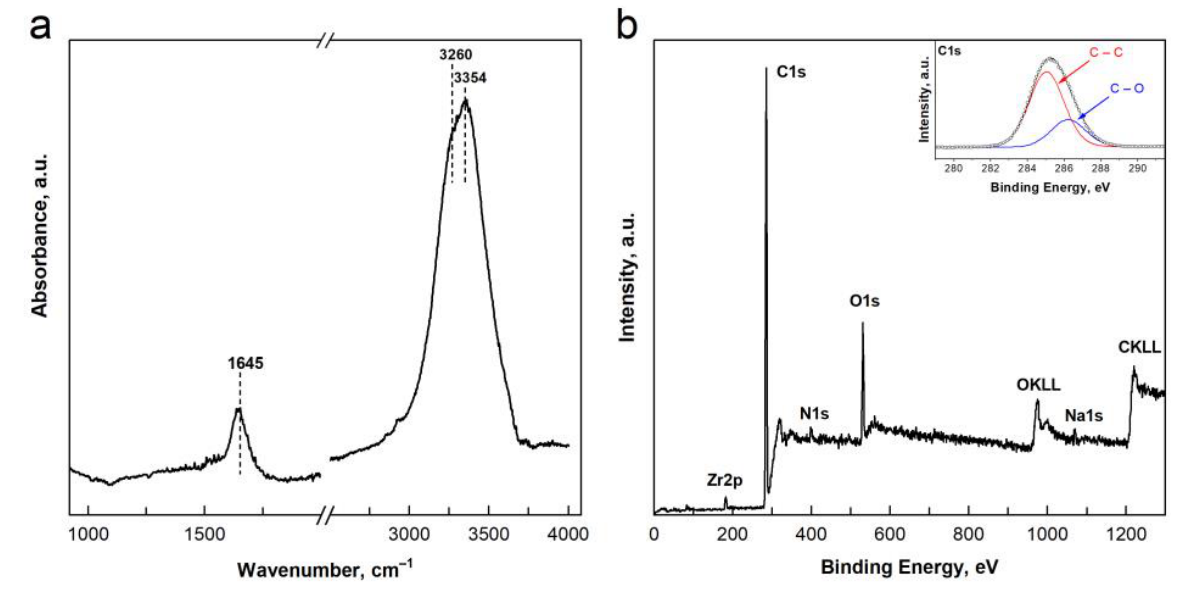
Figure 1. Characterisation of the surface chemical composition of hydroxylated ND particles. ( a ) FT- IR spectrum of hNDs in the 1000–4000 cm −1 range. ( b ) XPS survey scan spectrum of hNDs and the high-energy resolution C1s spectrum (insert).